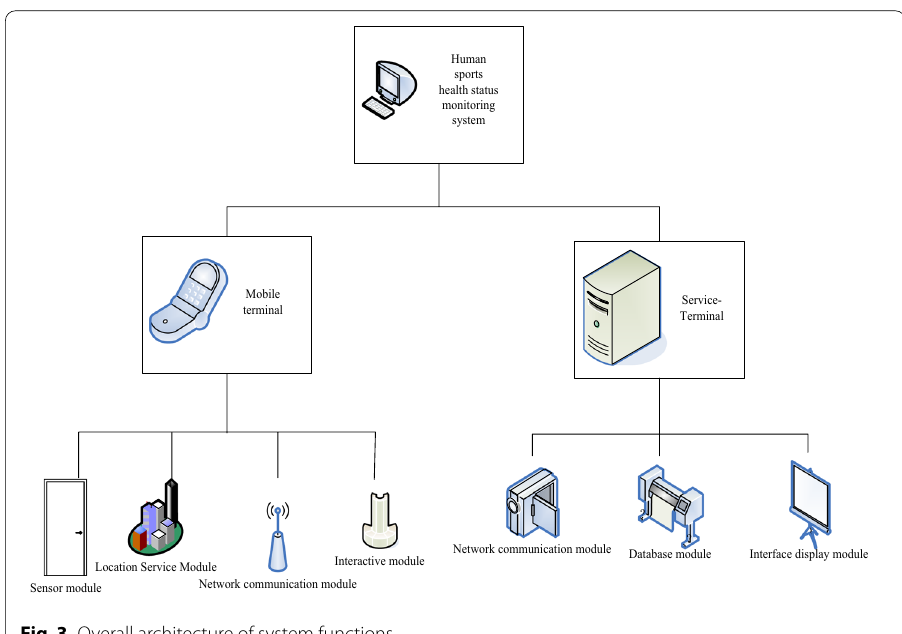
Fig. 3 Overall architecture of system functions